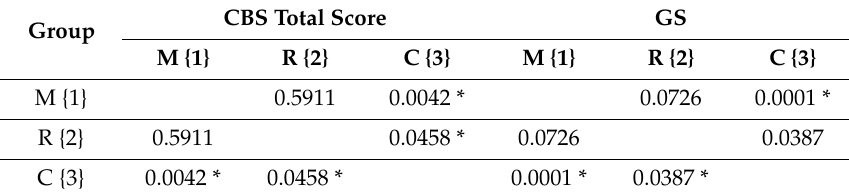
Table 3. Sche ff e’s post hoc test for the CBS variables (total score and GS) between the massage (M), relaxation (R) and control (C)